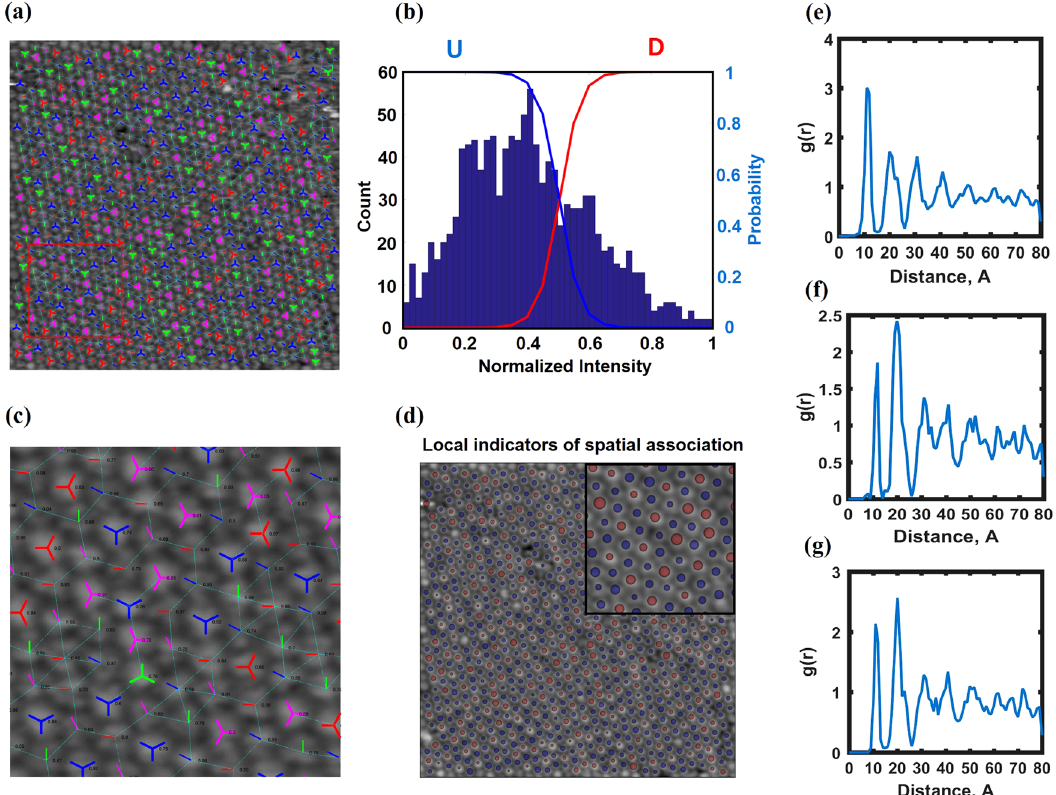
Fig. 6 Application of MRF and cNN to experimental data of buckybowls on gold (111). a Decoding of bowl-up/down states ( p = 7) and rotational states for the experimental image described in Fig. 1c. For cNN analysis, an additional MRF re fi nement of rotational classes was performed using the same probabilities as for the synthetic data. b Histogram of STM intensities for all identi fi ed molecules. c Zoomed-in area from red rectangle in a where numbers denote an accuracy of state determination. d Spatial correlation analysis based on local Moran ’ s I statistics. The molecules are color-coded such that molecules in D and U states are presented as red and blue circles respectively; the size of the marker is scaled such that it is proportional to a value of local Moran ’ s I . e – g Pair correlation function constructed from decoded experimental data for all molecular states e , only bowl-down states f , and one of the rotational classes g . See also Supplementary Figure